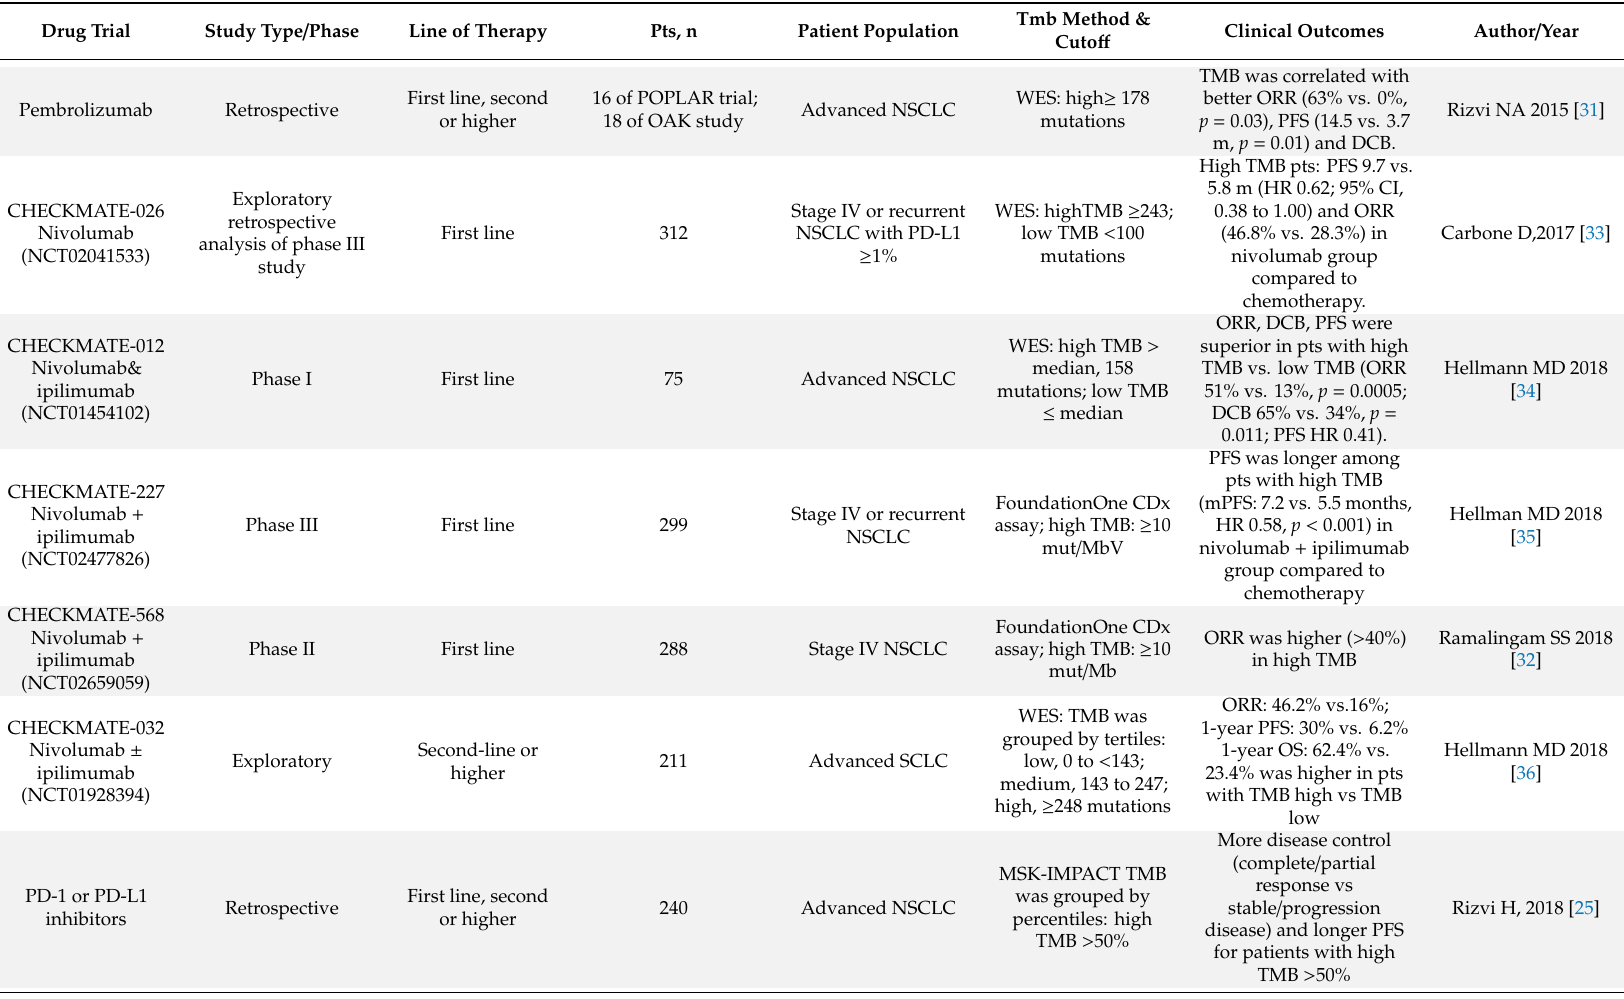
Table 1. Studies on tumor mutational burden (TMB) analysis as a biomarker of response to immune checkpoint inhibitors